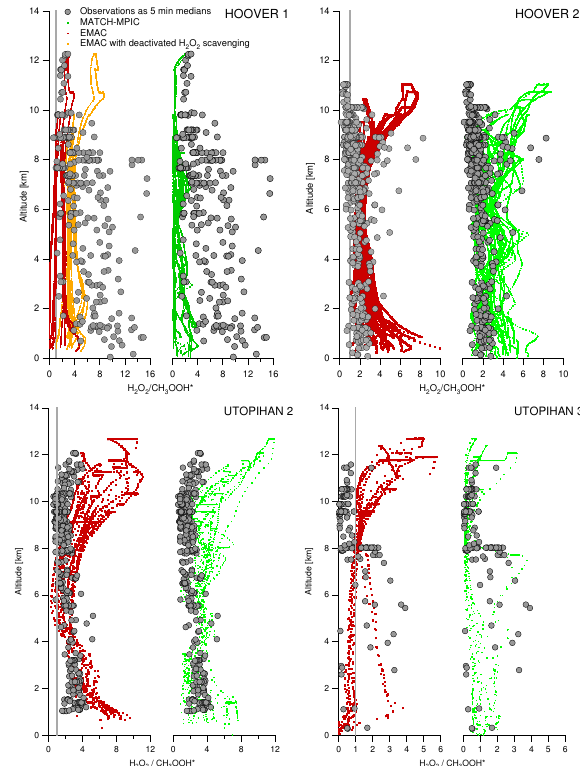
Fig. 11. The ratio H 2 O 2 /CH 3 OOH ∗ as a function of altitude for UTOPIHAN 2, 3 and HOOVER 1, 2. Grey dots show observations averaged over 5 min, red dots show data from the EMAC model, orange dots show EMAC data with deactivated cloud scavenging for H 2 O 2 and green dots show MATCH-MPIC data.